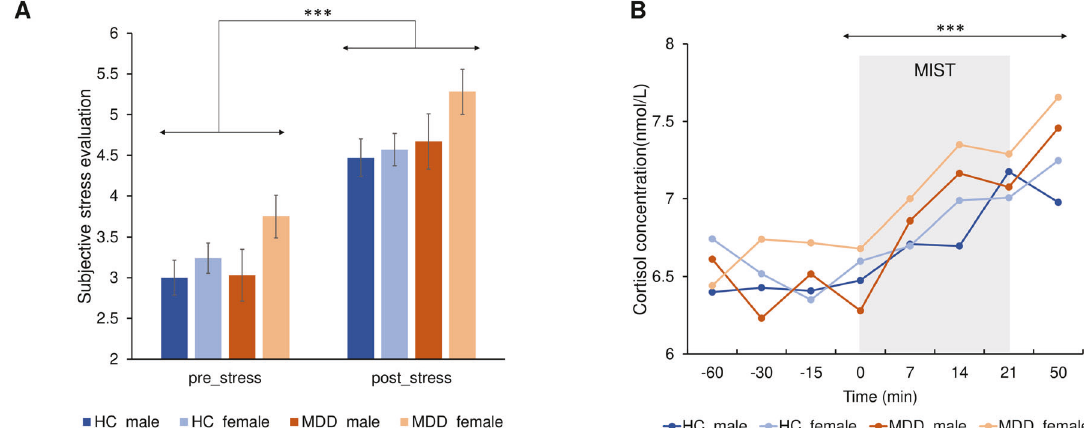
Fig. 2 Subjective and cortisol stress responses. A All four groups exhibited higher post-MIST subjective stress evaluation level in comparison to the pre-MIST subjective stress level. Estimated-mean are plotted, and the error bar represent SE. B Signi fi cant main effect of time in cortisol concentration over the stress exposure. *** p Bonferroni < 0.001. HC healthy controls, MDD major depressive disorder, MIST Montreal Imaging Stress